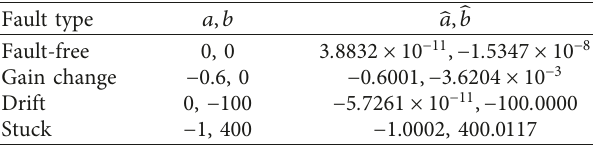
Table 8: Fitting results under different types of faults.